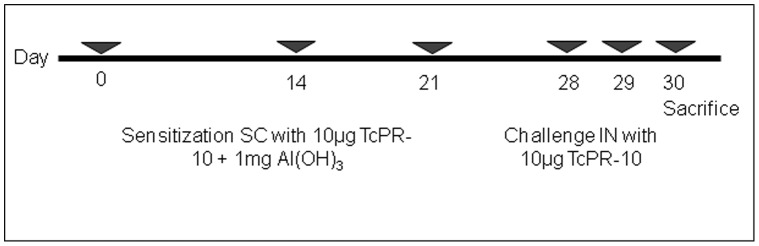
Experimental design of sensitization and challenge with TcPR-10 wild types and mutant.